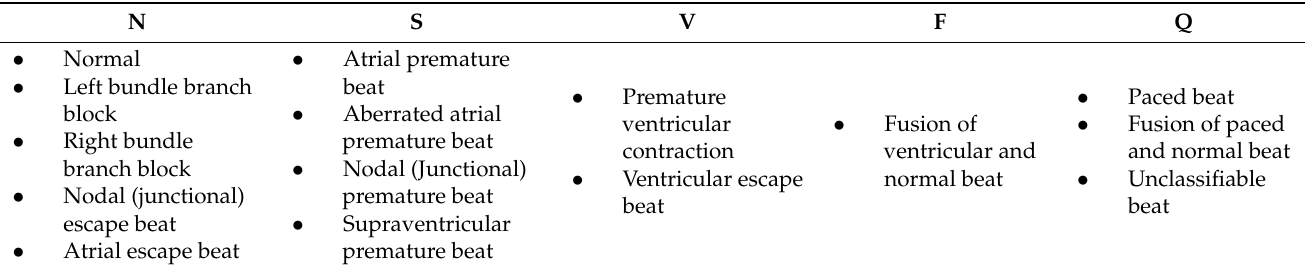
Table 1. Heartbeats of the MIT-BIH arrhythmia database classified based on the ANSI/AAMI EC57:1998 standard.